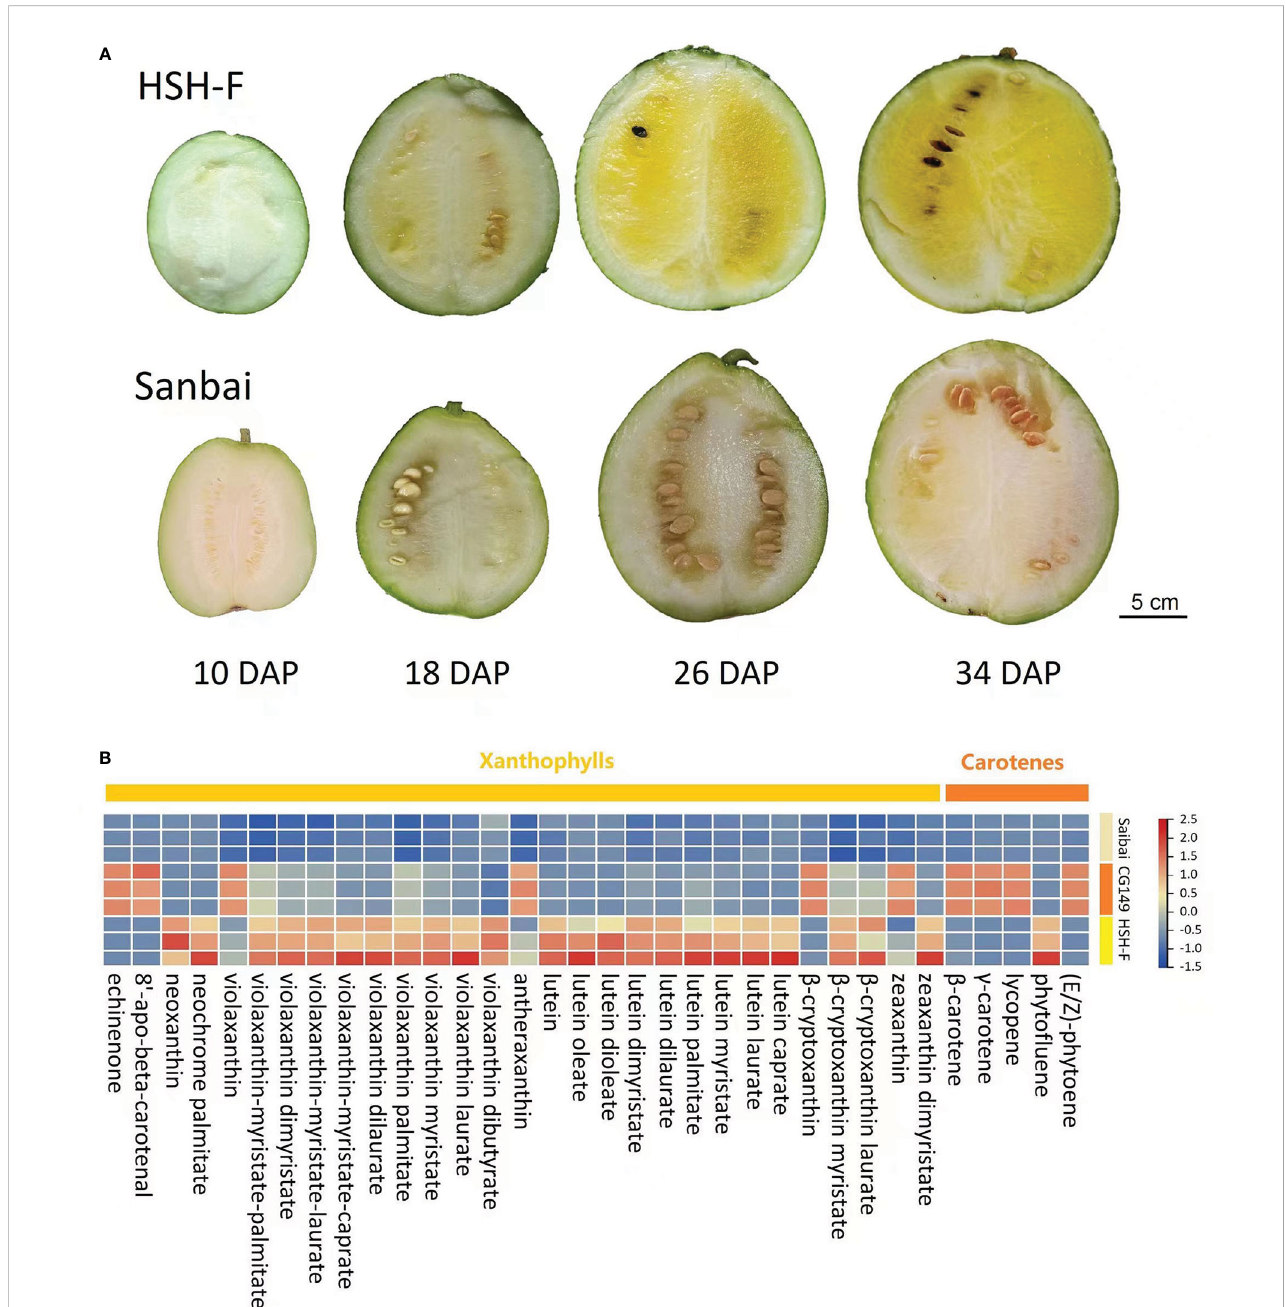
FIGURE 1 Characterization of the fl esh color formation and carotenoid content of parental lines. (A) Fruits at 10, 18, 26, and 34 days after pollination (DAP) of HSH- F and Sanbai. (B) Heatmap of the carotenoid content of fruits from the parental lines at 34